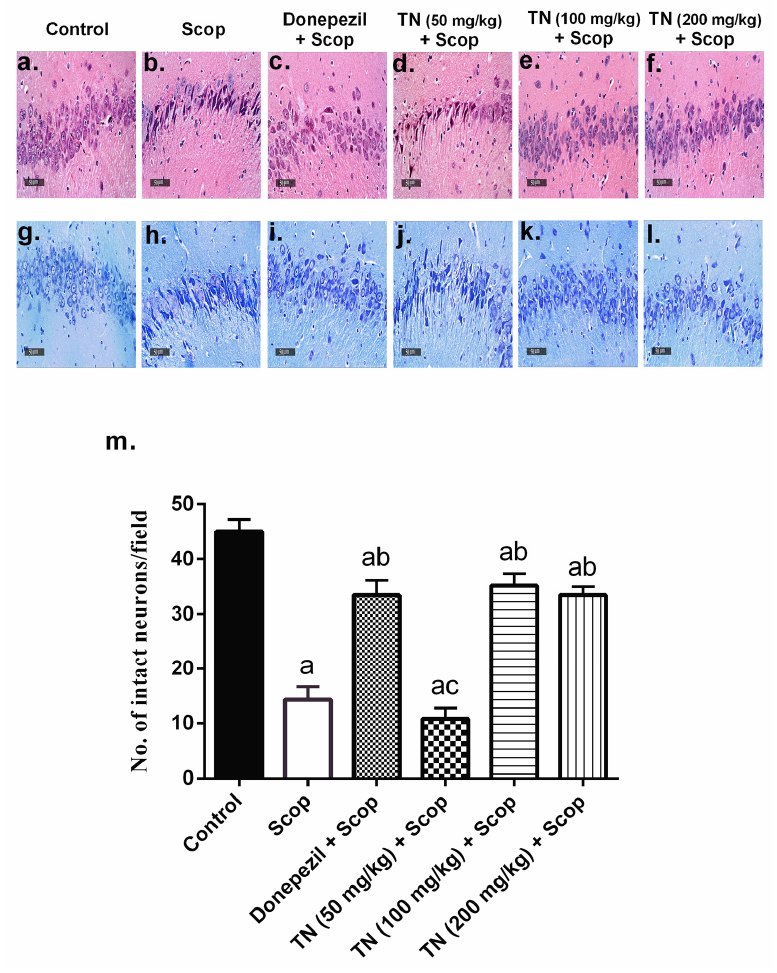
Figure 8. Effect of different doses of TN on Scop-induced histopathological alterations and neuronal loss. ( a – f ): specimens stained with H&E (400 x magnification). ( a ) The control group showed a nor- mal hippocampal structure; ( b ) the Scop group showed severe neuronal necrosis and extensive glio- sis; ( c ) the donepezil group showed minimal neurodegenerative changes and persistent gliosis; ( d ) the TN 50 mg group showed severe neuronal necrosis and extensive gliosis; ( e ) the TN 100 mg group showed minimal neurodegenerative changes; ( f ) the TN 200 mg group showed minimal neuro- degenerative changes and diminished gliosis. ( g – l ) Specimens stained with Nissl (400 x magnifica- tion). ( m ) Number of Nissl-stained cells (intact neurons). Statistical analysis was carried out using one-way ANOVA followed by the Tukey–Kramer multiple comparison test. Values are expressed as the mean ± SD. Values are statistically significant at p < 0.05 versus the control group, p < 0.05 versus the Scop-treated group and p < 0.05 versus donepezil-treated group. 3. Discussion TN extract offers antioxidant [44,45], anti-inflammatory, neuroprotective [46] and beneficial effects in memory-related disorders [47]. Therefore, the aim of the present study was to investigate the protective effect of TN extract on Scop-induced memory impair-